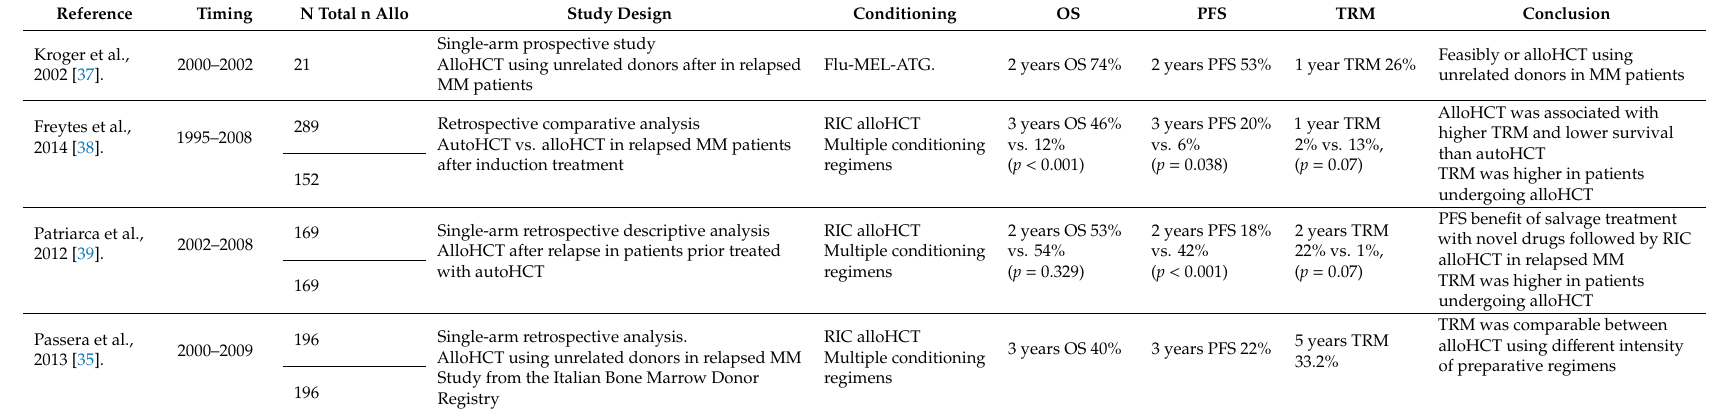
Table 2. Main studies related to the use of allogeneic hematopoietic cell transplantation in the relapsed / refractory